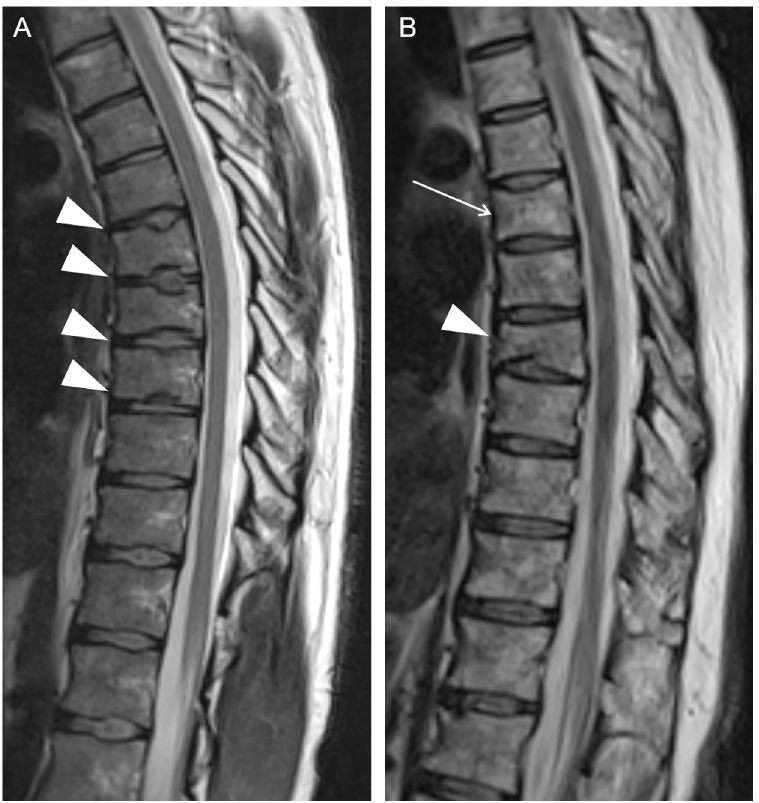
Fig 2. Representative spinal magnetic resonance imaging (MRI) showing vertebral changes on T2-weighted (T2W) sagittal images. Several adjacent flat thoracic vertebrae with end-plate irregularities are demonstrated on T2W image of a male aged 31 years (A, arrowheads). T2W image of a female aged 43 years demonstrates slightly compressed Th6 vertebra, Genant’s grade 1 (B, arrow) and vertebral fracture of Th8, Genant’s grade 2 (B, arrowhead).